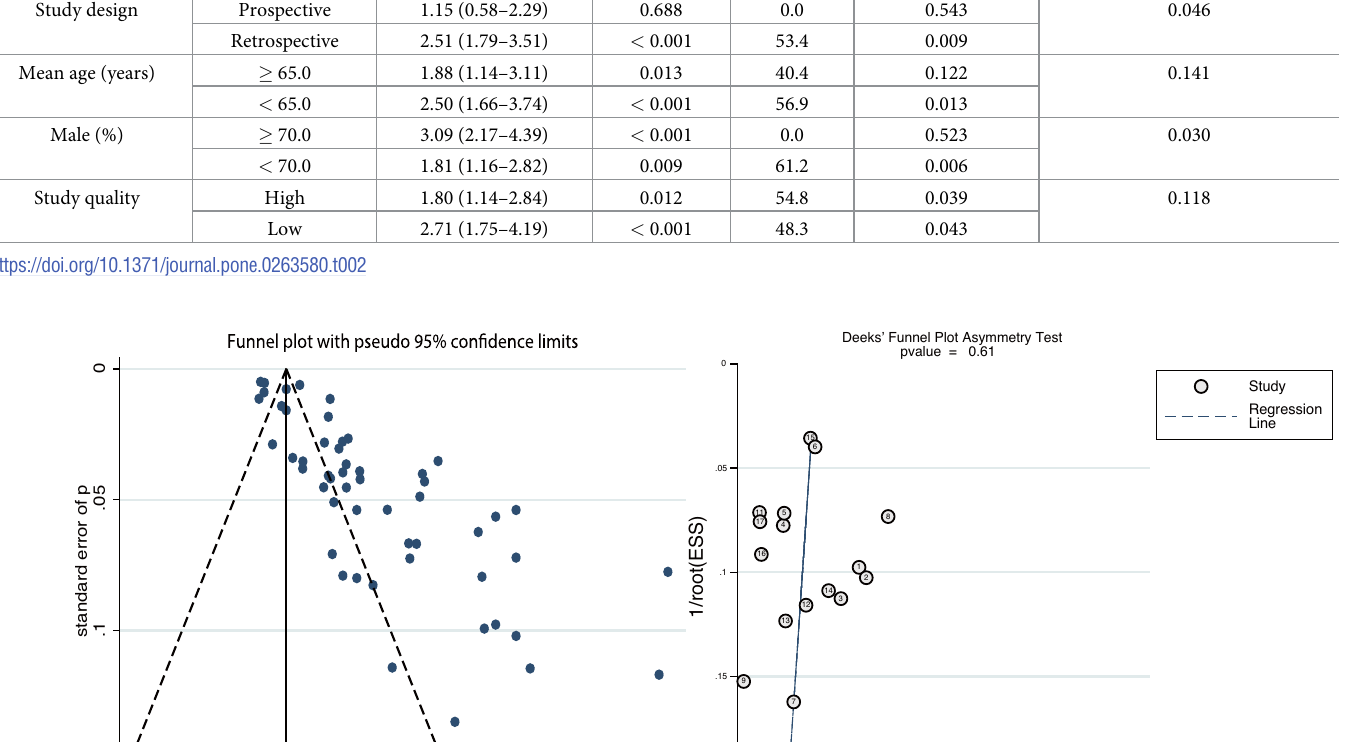
P value for Egger: < 0.001 P value for Begg: < 0.001